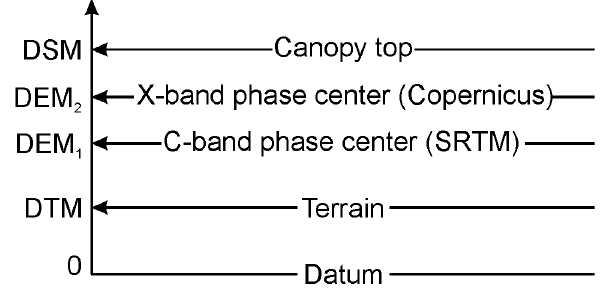
Figure 3 . Different DEM evation types available over forested area: DTM represents bare terrain elevation; DEM 1 represents the C-band phase centre or SRTM elevation; DEM 2 represents the X-band phase centre or Copernicus elevation; DSM (or Digital Surface Model) is the elevation of the forest canopy. The DTM/DSM are not available from the InSAR-derived elevation data products over forested